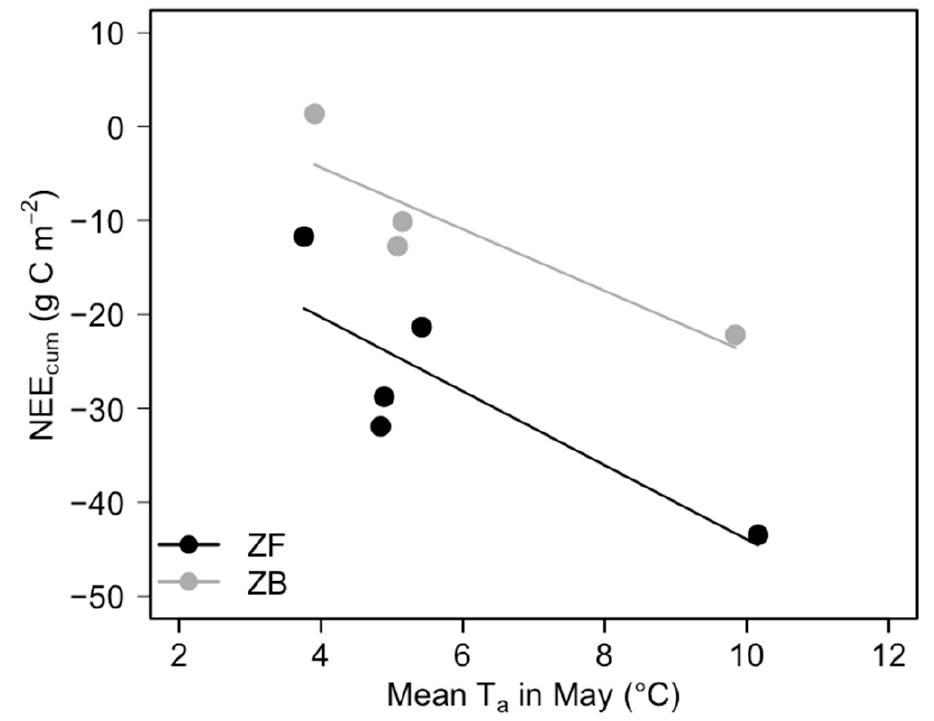
Figure 5. Relationships between cumulative NEE (NEE cum ; g C m − 2 ) and mean T a in May ( ◦ C) from 2013 to 2017 for the ZF and ZB sites. Linear regression for ZF (black dot and line): NEE cum = − 4.52*T a − 3.94, R 2 = 0.69, P = 0.081; linear regression for ZB (grey dot and line): 8.77*T a − 3.28, R 2 = 0.79, P = 0.110. NEE cum was calculated from DOY 110–155 in 2013 only for